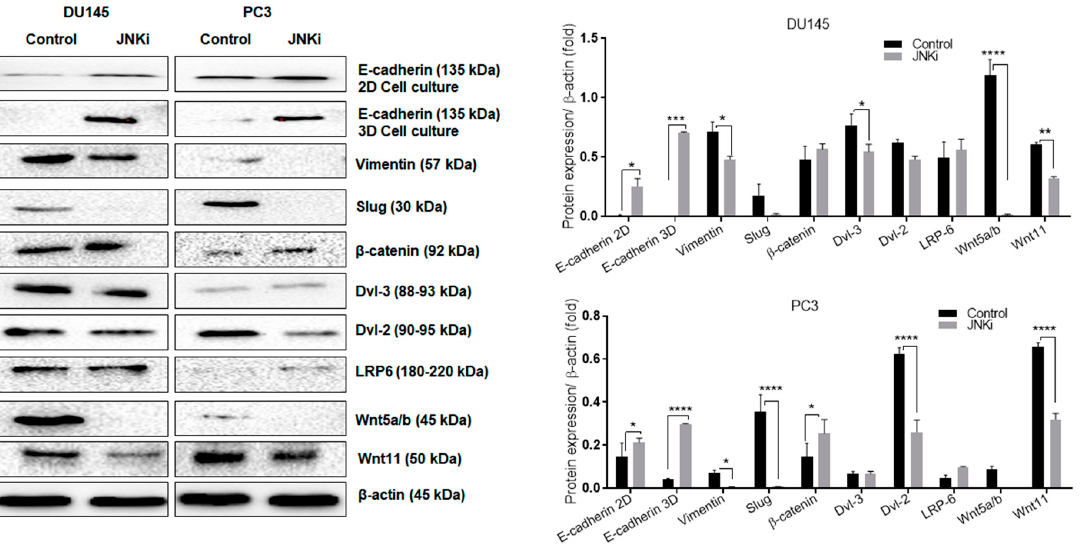
Figure 4. The inhibition of JNK reduces the epithelial–mesenchymal transition (EMT) process in both DU145 and PC-3 cells. Total protein isolation proceeded following JNKi treatment in DU145 and PC-3 cells. Additionally, the total protein was isolated from hanging drop spheroids in DU145 and PC-3 cells, as well as E-cadherin, vimentin, Slug, β -catenin, Dvl-3, Dvl-2, LRP6, and Wnt5a / b and Wnt11. β -actin was used as a loading control. Expression levels were analyzed by ImageJ and are presented as column graphics. DU145 E-cadherin (two-dimensional; 2D): * p = 0.0213; vimentin: * p = 0.0334; Dvl-3: * p = 0.0396, ** p = 0.0042, **** p < 0.0001; PC-3 E-cadherin (2D): * p = 0.022, Vimentin: * p =